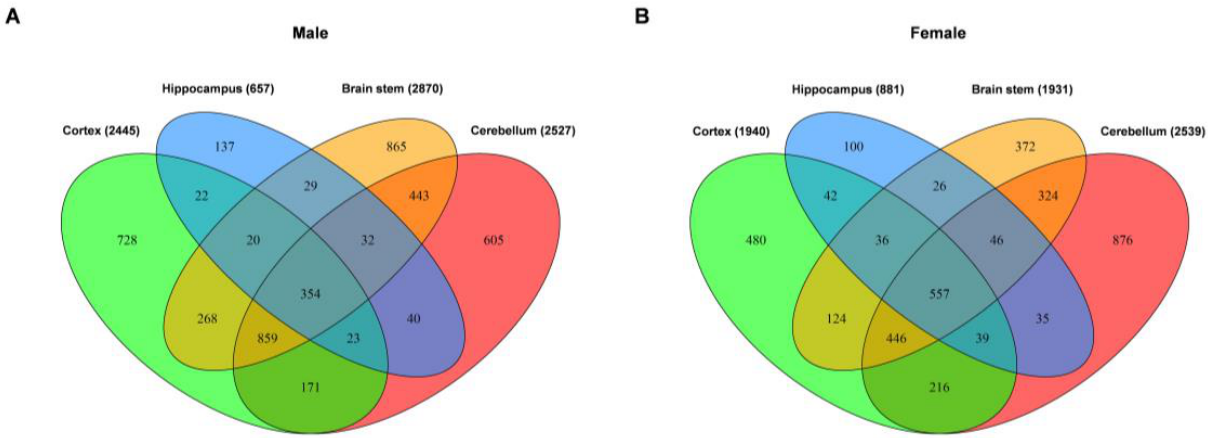
Figure 3. Venn analysis of the differentially expressed genes in different brain region tissues of male ( A ) and female ( B ) DAPK1-KO mice.